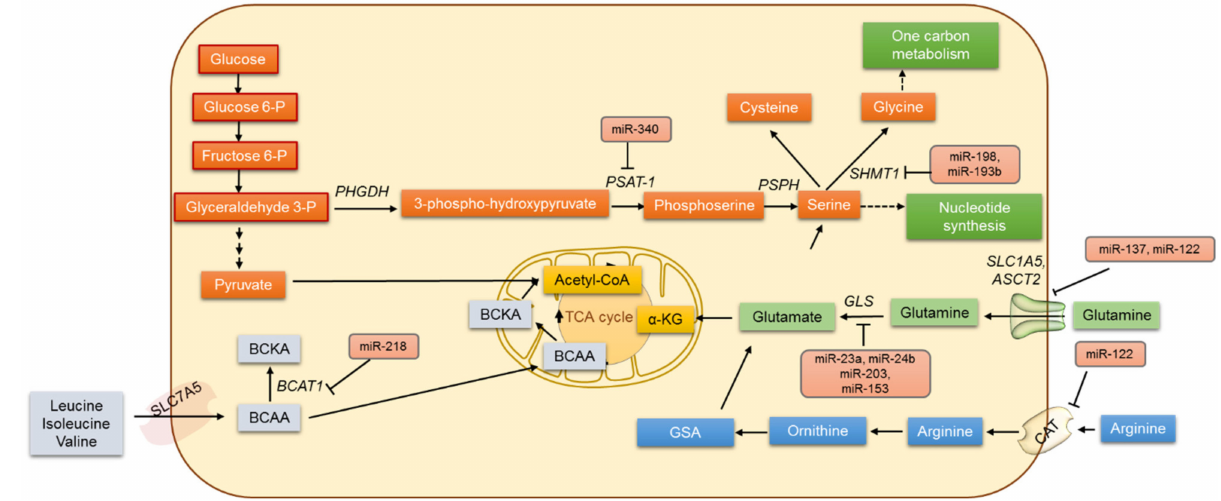
Figure 2. The regulation of amino acid cancer metabolism by